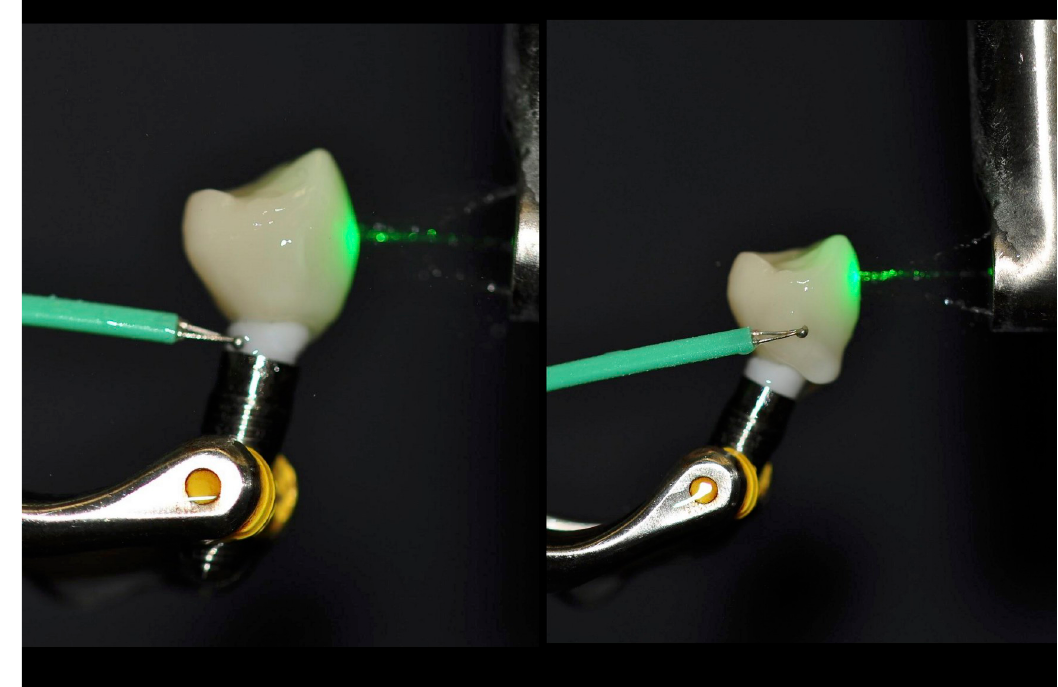
Fig 2. Temperature measurements of crown and abutment during laser